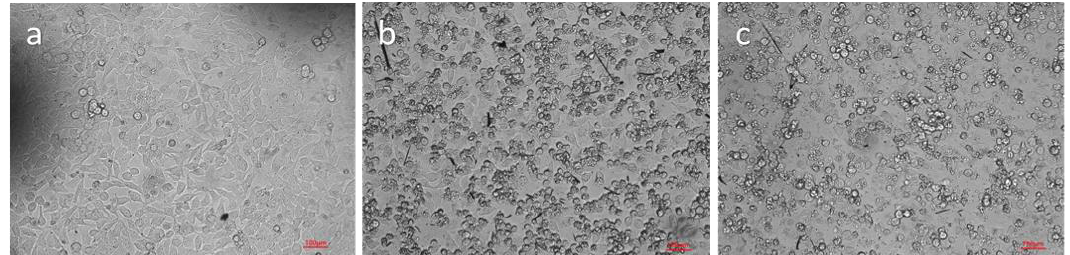
Figure 9. Microscopy images of HeLa cells: Control group ( a ), cultured with CUR-PC ( b ), and cultured with CUR-PC, then exposed to long-wavelength light irradiation ( c ). Scale bar = 100 μm.